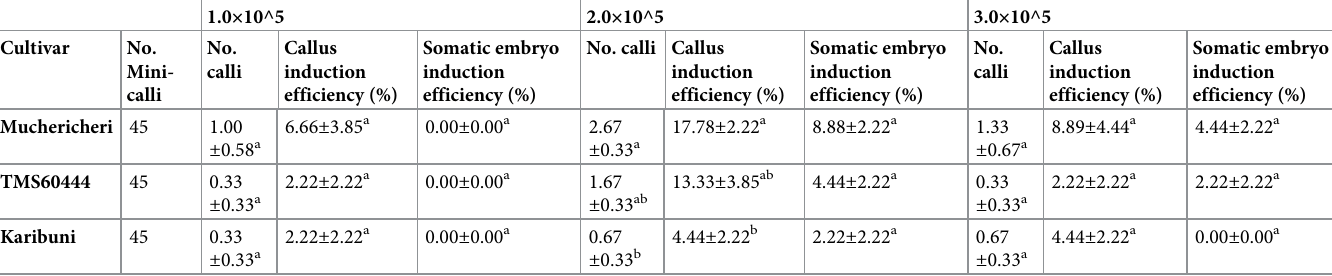
Table 4. Effects of cell density on minicalli development and somatic embryogenic calli induction.